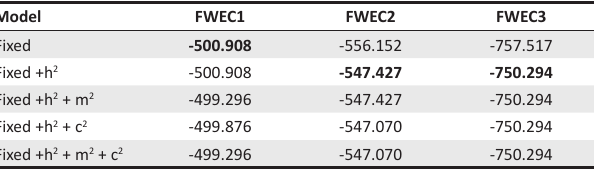
TABLE 2: Log-likelihood ratios for single-trait random effects model fitted to faecal worm egg count data of the Tygerhoek Merino flock with the ‘best’ model in bold.